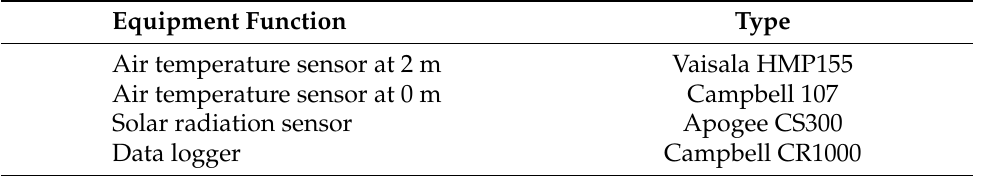
Table 1. Reference weather station